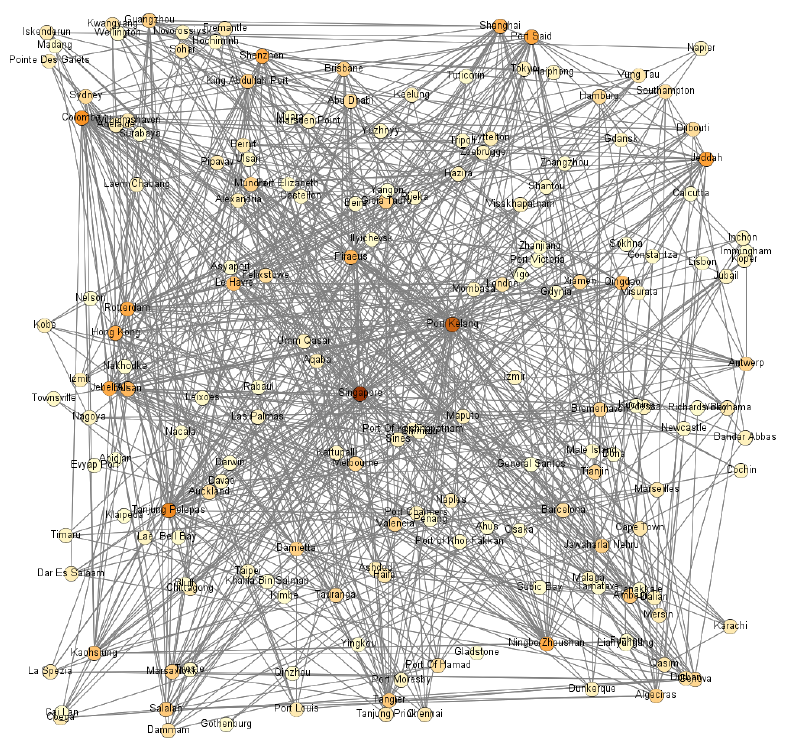
Figure 3. Undirected unweighted MSR shipping network.